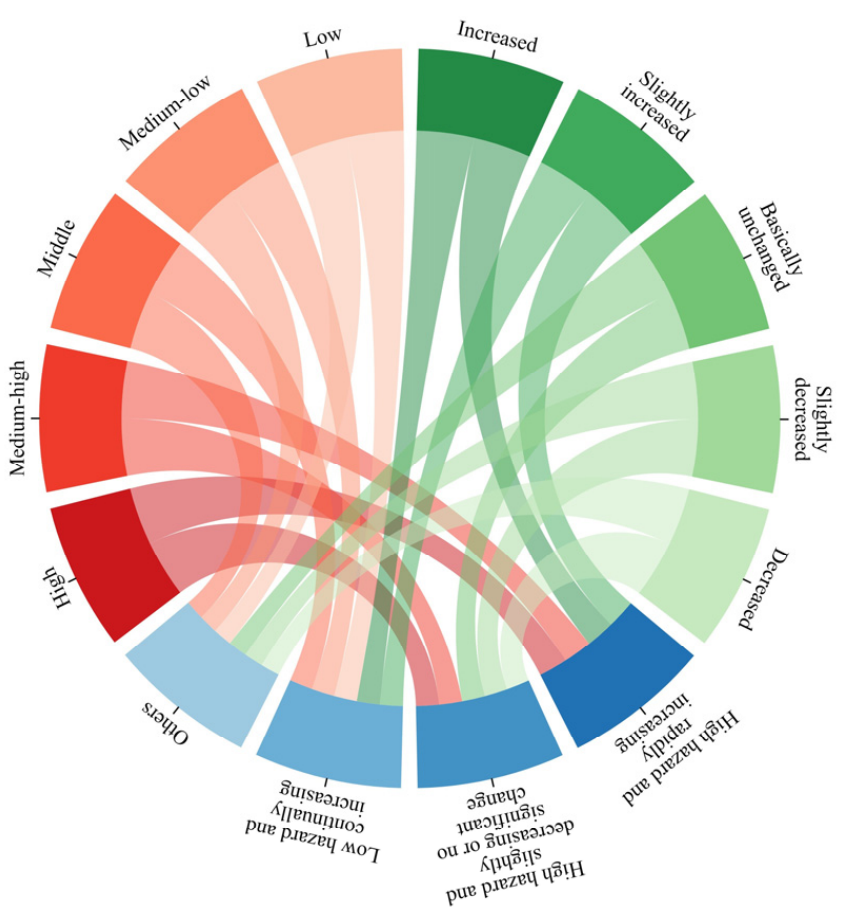
Figure 2. The standard for spatiotemporal classifications of heatwave hazards. The red and green sections represent the spatial distribution and temporal change classifications of heatwave hazards, respectively, while the blue section represents the spatiotemporal classification of heatwave hazards.